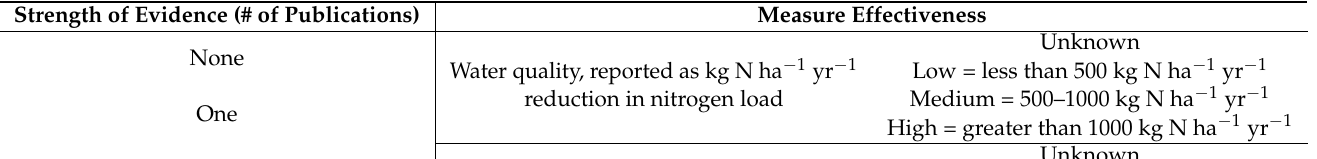
Table 2. Scoring rubric.